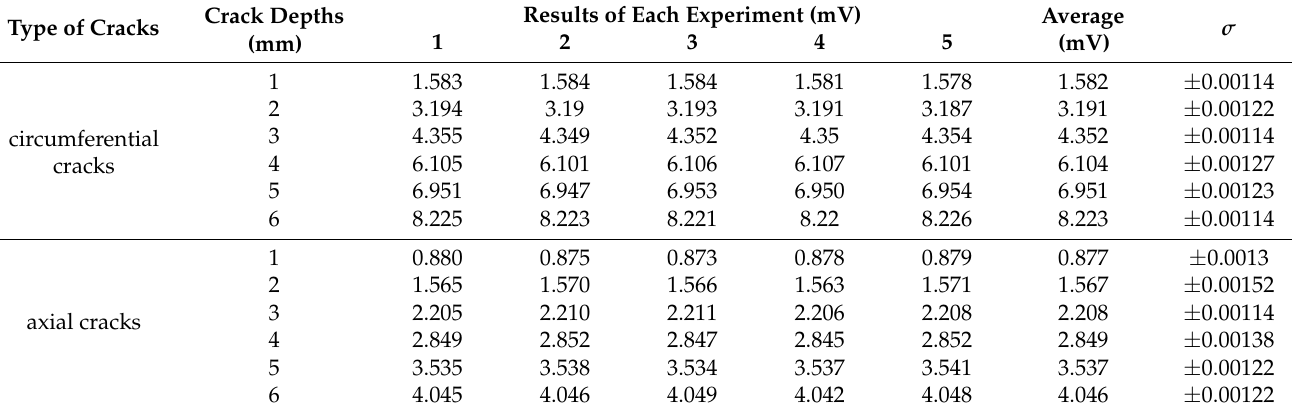
Table 2. Uncertainty of experimental